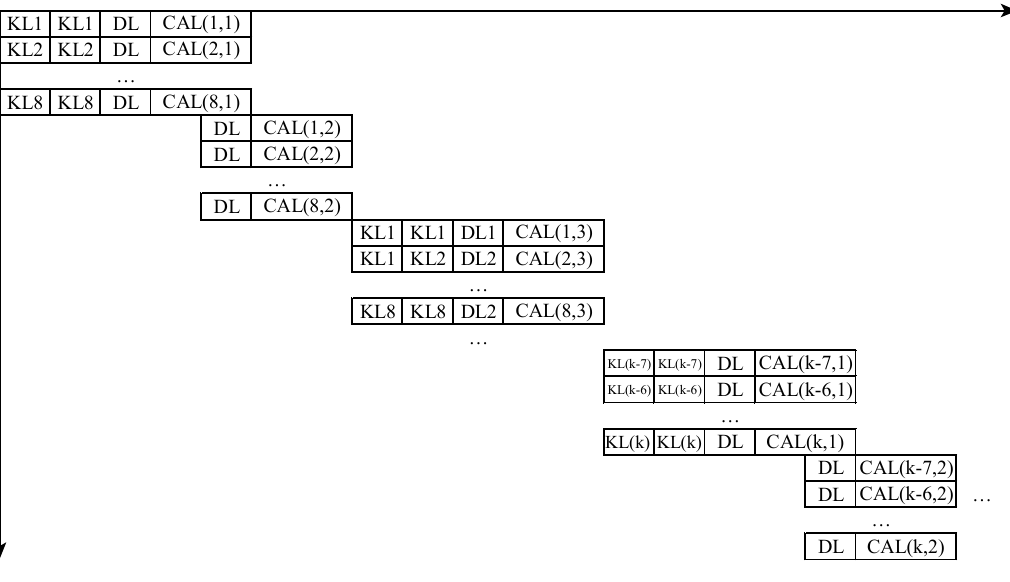
Figure 8. The first strategy of Full Connected layer.